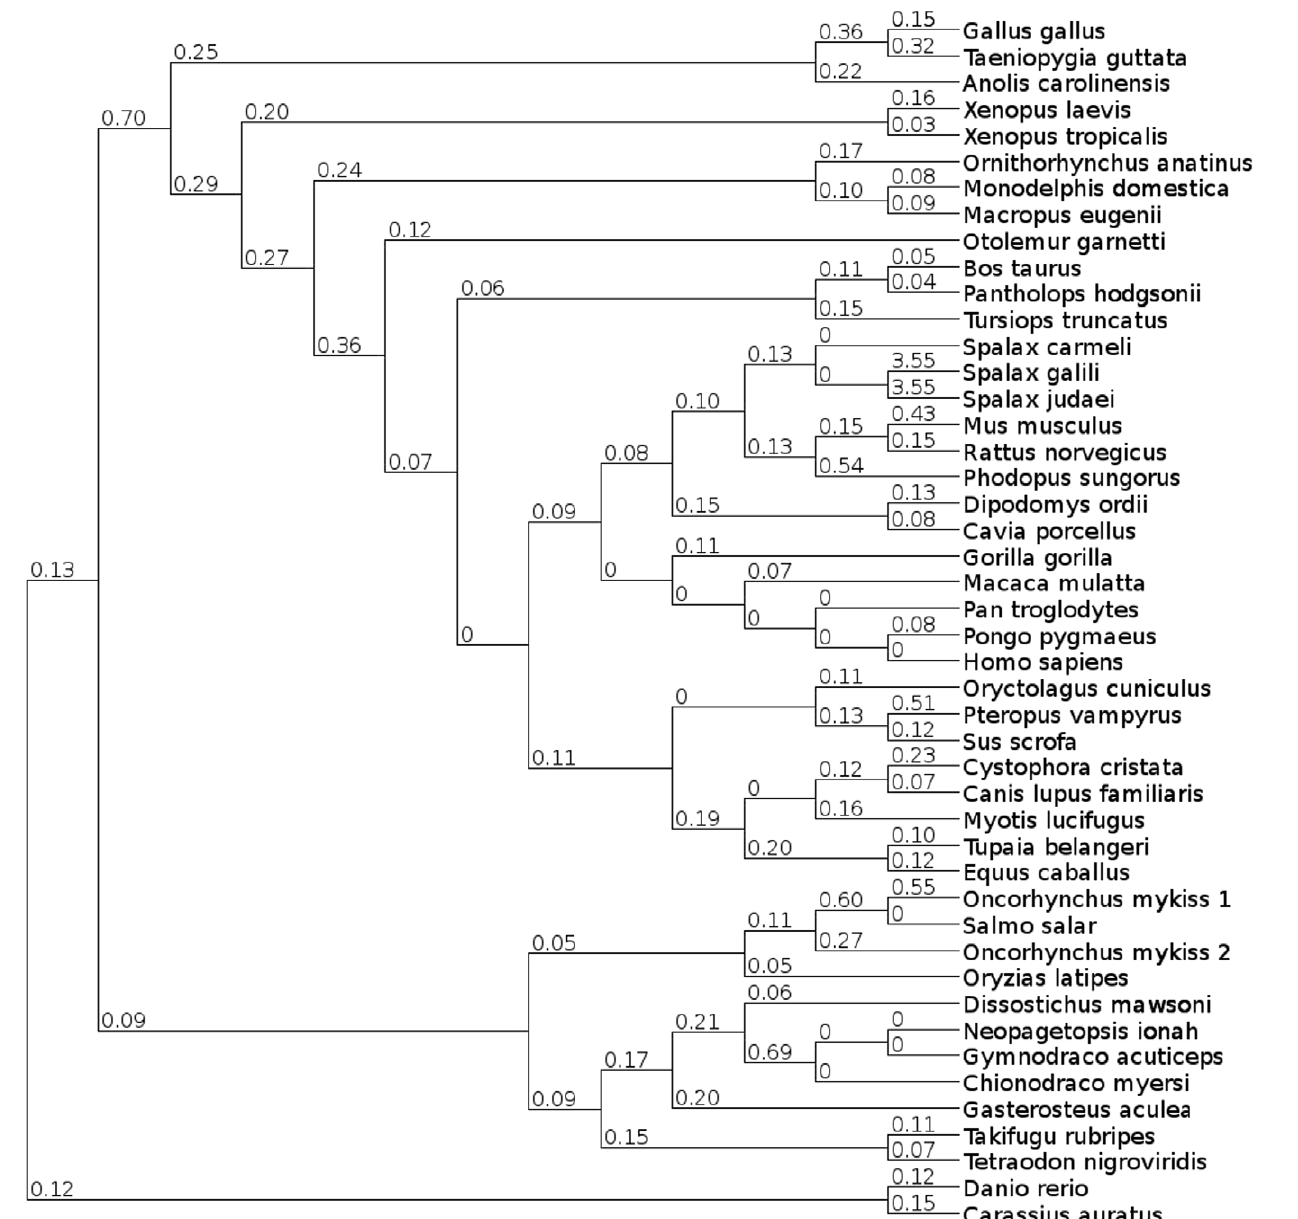
Figure 5. Ka/Ks ratios of several vertebrate Ngb proteins. Shown is a neighbor joining tree with Ka/Ks ratios indicated above the branches. Expect for branches leading to S. galili and S. judaei , no values above one were observed indicating strong purifying selection.